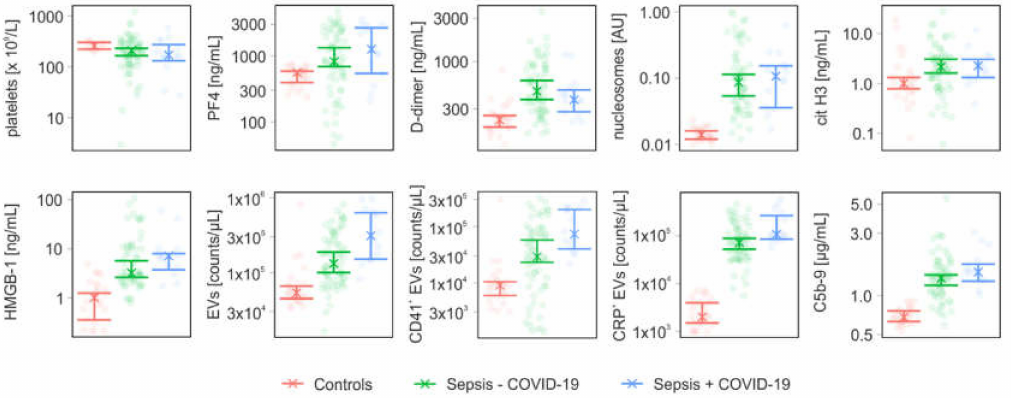
Figure 1. Levels of coagulation- and complement-related parameters in sepsis patients (Sep- sis − COVID-19), sepsis patients diagnosed with COVID-19 (Sepsis + COVID-19), and healthy controls. The x represents the median of the measurements. (PF4, platelet factor 4; cit H3, citrullinated histone H3; HMGB-1, high mobility group box-1 protein; EVs, extracellular vesicles; CRP, C-reactive protein; C5b-9, terminal complement